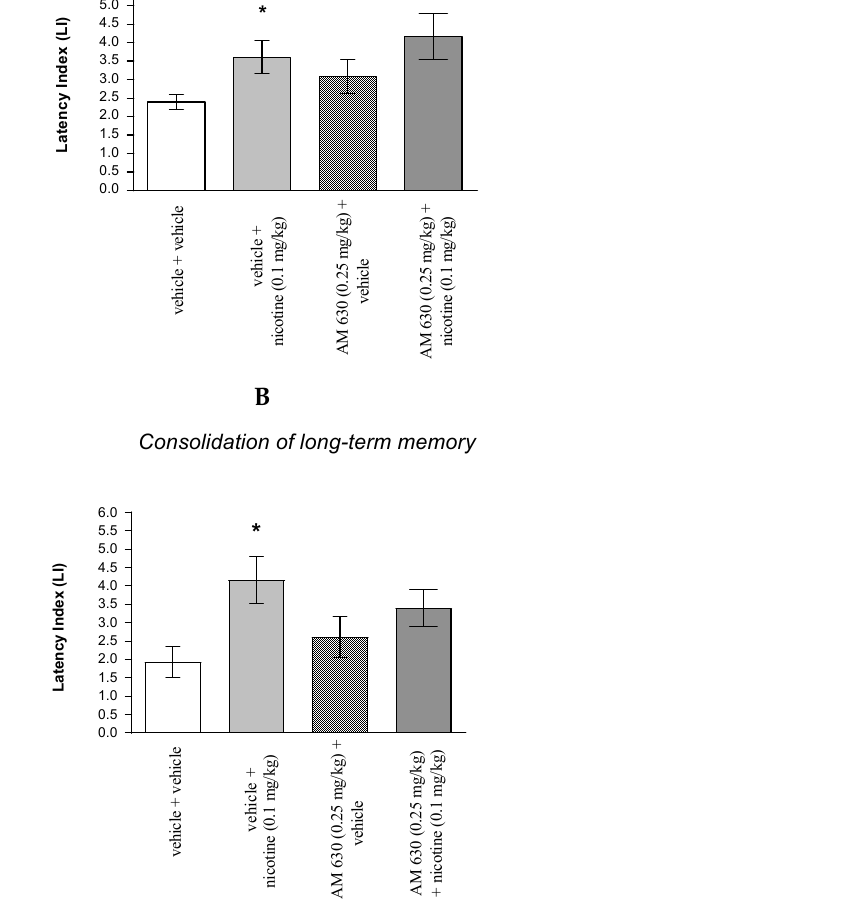
Figure 7. The influence of an acute co-administration of CB2-receptor antagonist and effective (pro-cognitive) dose of nicotine on the cognition-related responses expressed as latency index (LI) during the acquisition ( A ) and consolidation ( B ) of memory using the PA test in mice. * p < 0.05 vs. vehicle/vehicle-treated mice.